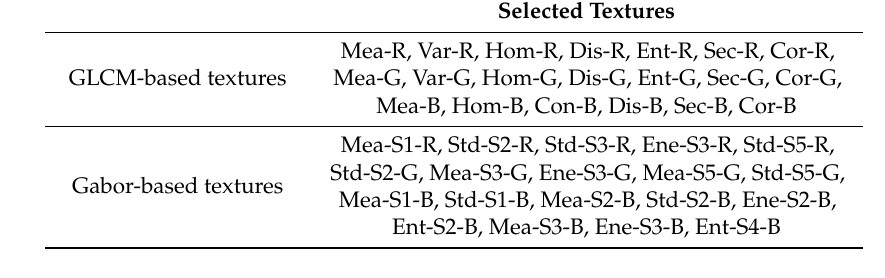
Table 4. The GLCM- and Gabor-based textures left after removing highly correlated features.